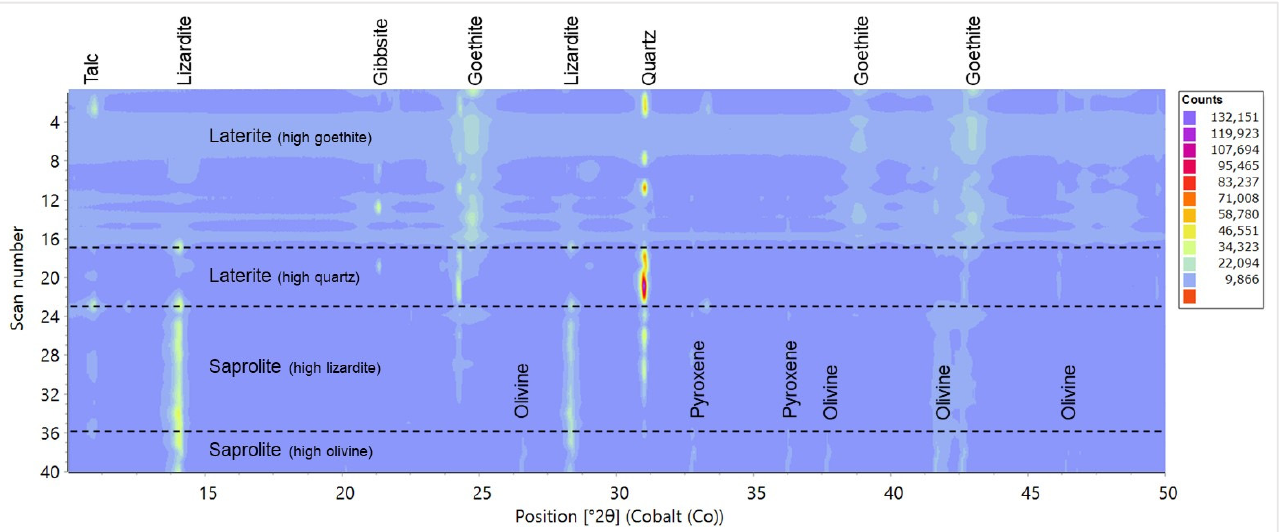
Figure 8. XRD s can surface plot of the region between 10° 2 θ and 50° 2 θ showing intensities of the main mineral phases. Figure 8. XRD scan surface plot of the region between 10 ◦ 2 θ and 50 ◦ 2 θ showing intensities of the main mineral phases. After mineral identification, the quantitative composition of the samples was de- termined using the Rietveld method. The Rietveld method is a full-pattern fit method. The measured profile and a profile calculated from crystal structure data are compared. By variation of many parameters, the difference between the two profiles is minimized. Structures and crystallographic data for all phases present in the samples are derived from the COD database, Table